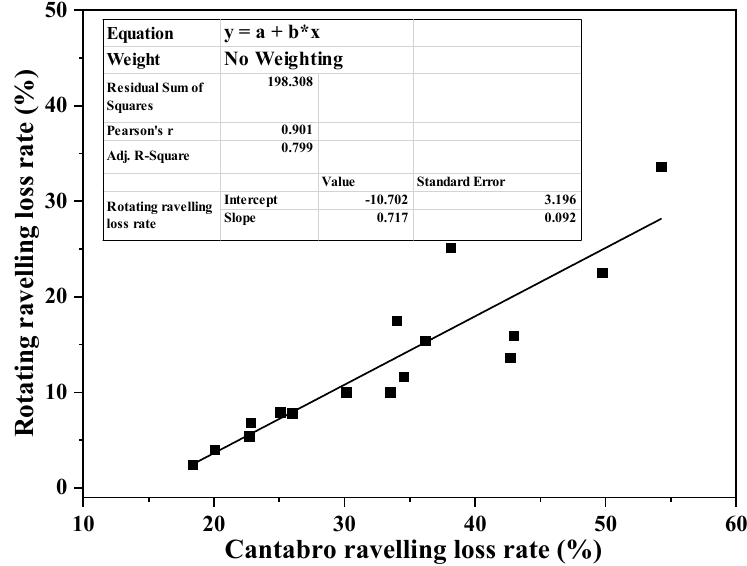
Figure 14. The correlation between the results of the Cantabro and Rotating Surface Abrasion tests.